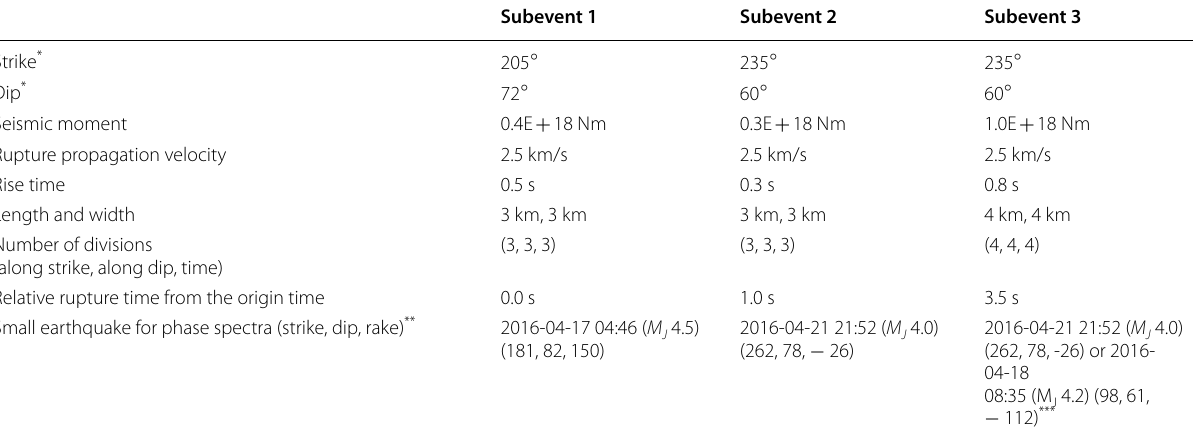
Table 4 Parameters of the earthquake of 2016/04/16 01:25 ( M